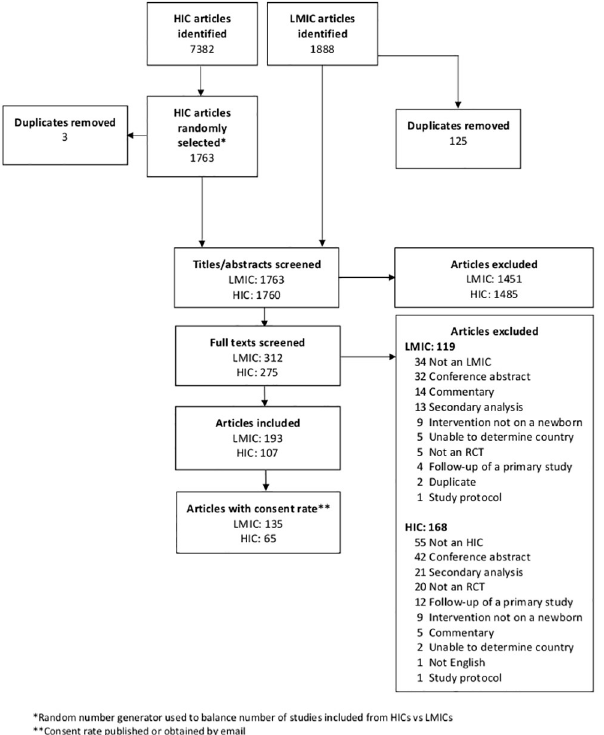
Fig 1. Summary of search process. Systematic search summary displayed as Consolidated Standards of Reporting Trials